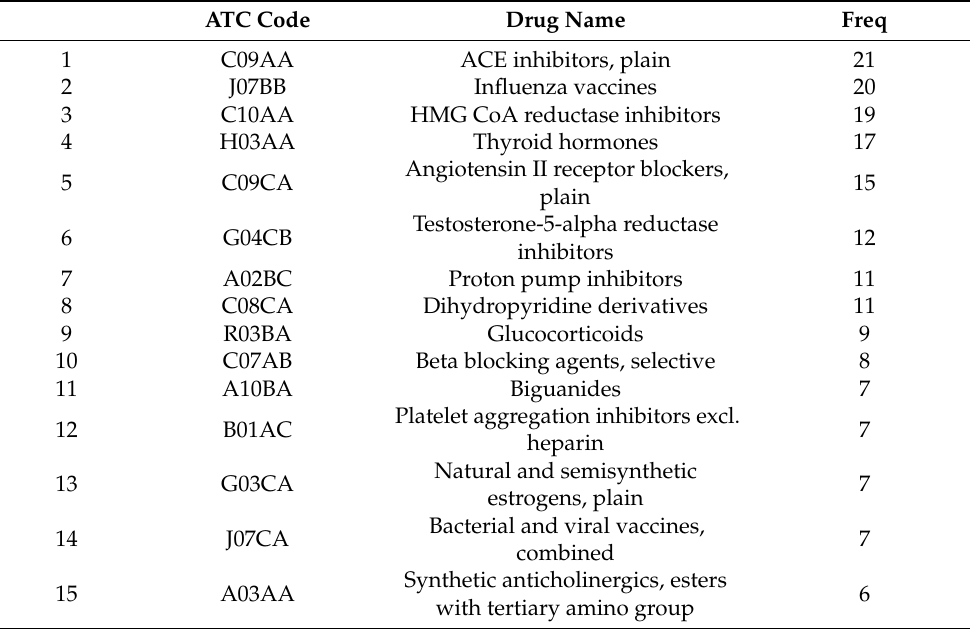
Table 4. Drugs showing consistent protective associations across 4 time-windows and 8 models (ranked by the frequency of being nominally significant, i.e., p < 0.05). ATC Code Drug Name Freq 1